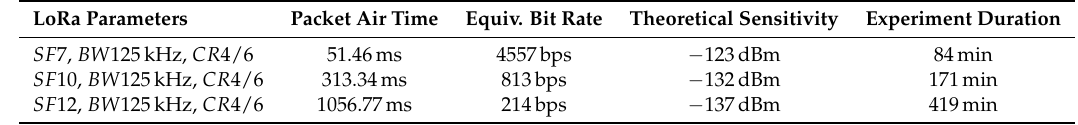
Table 3. Experiments’ technical details.